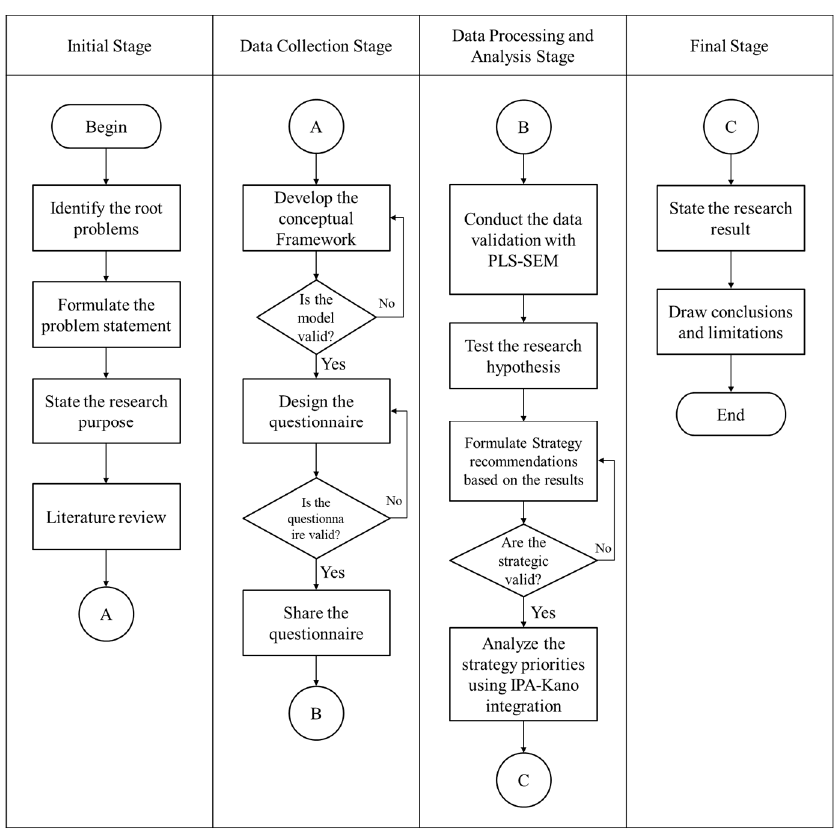
Figure 1. Research Methodology Flow Chart.